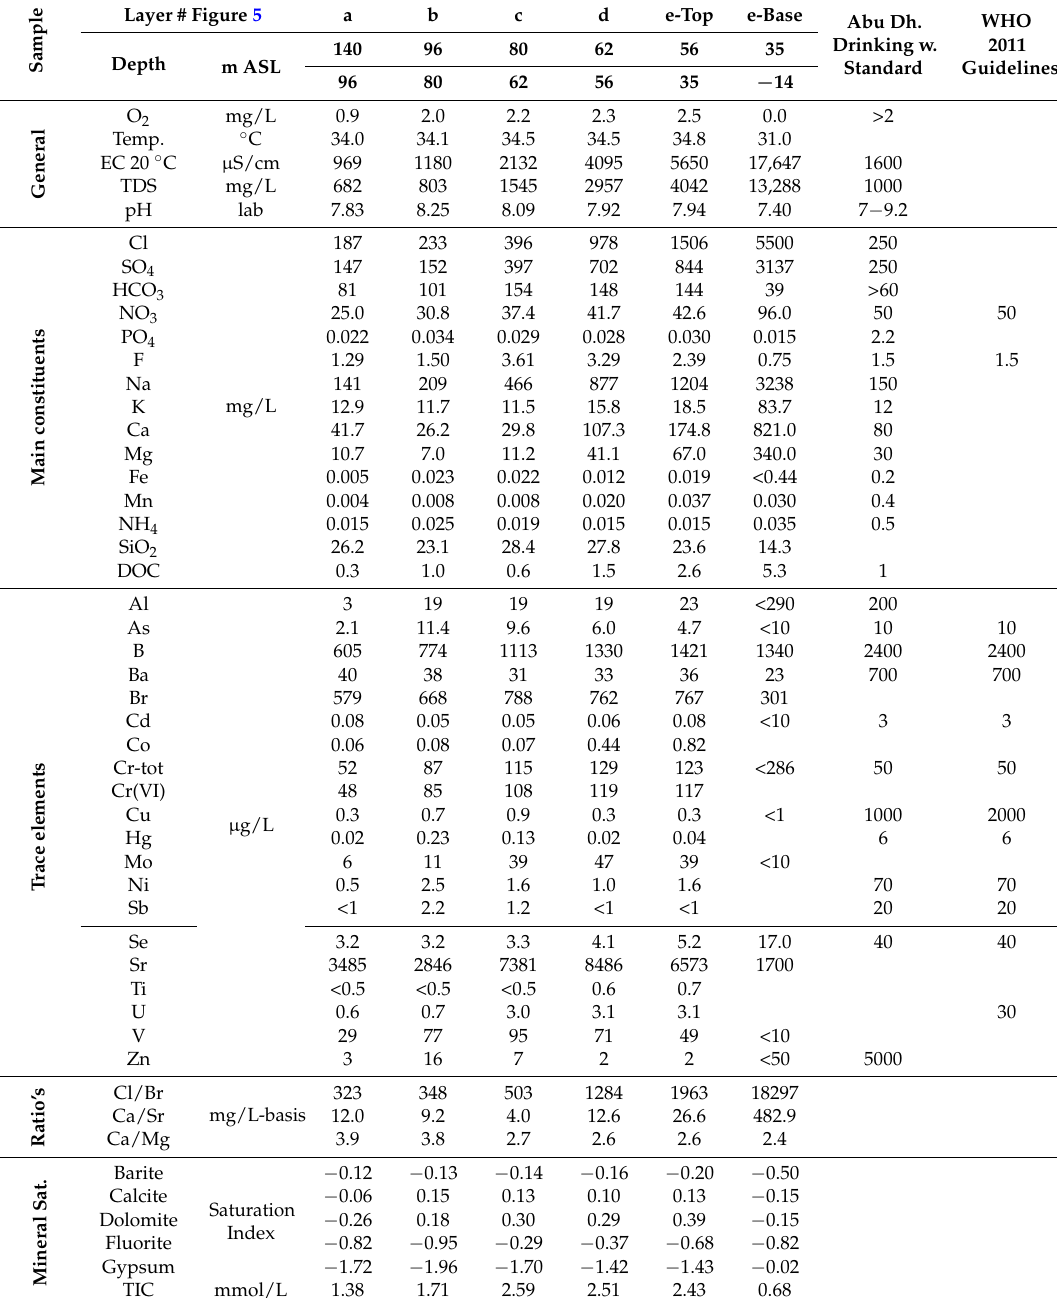
Table 2. Simplified chemical stratification of the native groundwater, averaged over both pilot and ABC plant areas. Aquifer 1 = layers a–c; Aquitard 1 = layer d; Aquifer 2 = layer e. Abu Dhabi drinking water standards according to [13], WHO guidelines according to [31], both with red numbers for parameters considered at risk during ASR recovery. All samples showed: Ag < 1, Be < 0.1, Pb < 5 µ